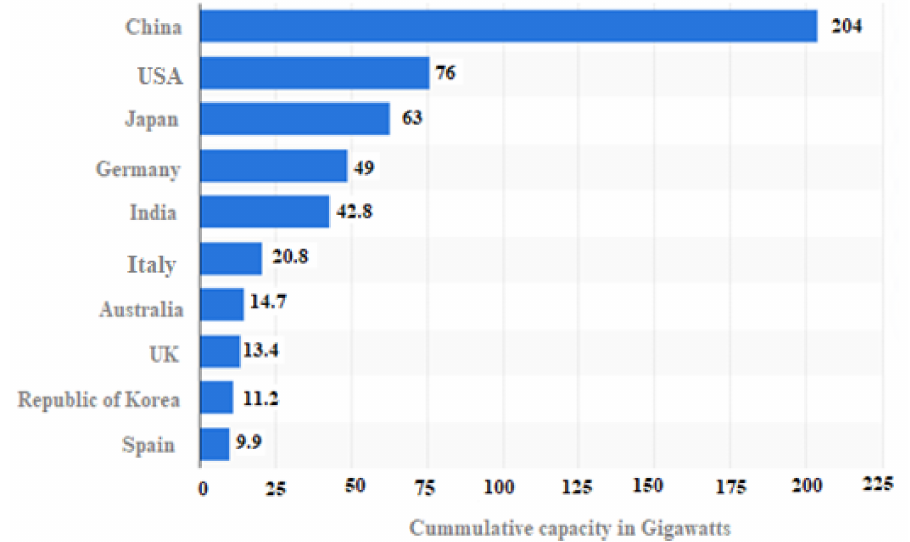
Figure 1. Global cumulative solar PV capacity in 2019